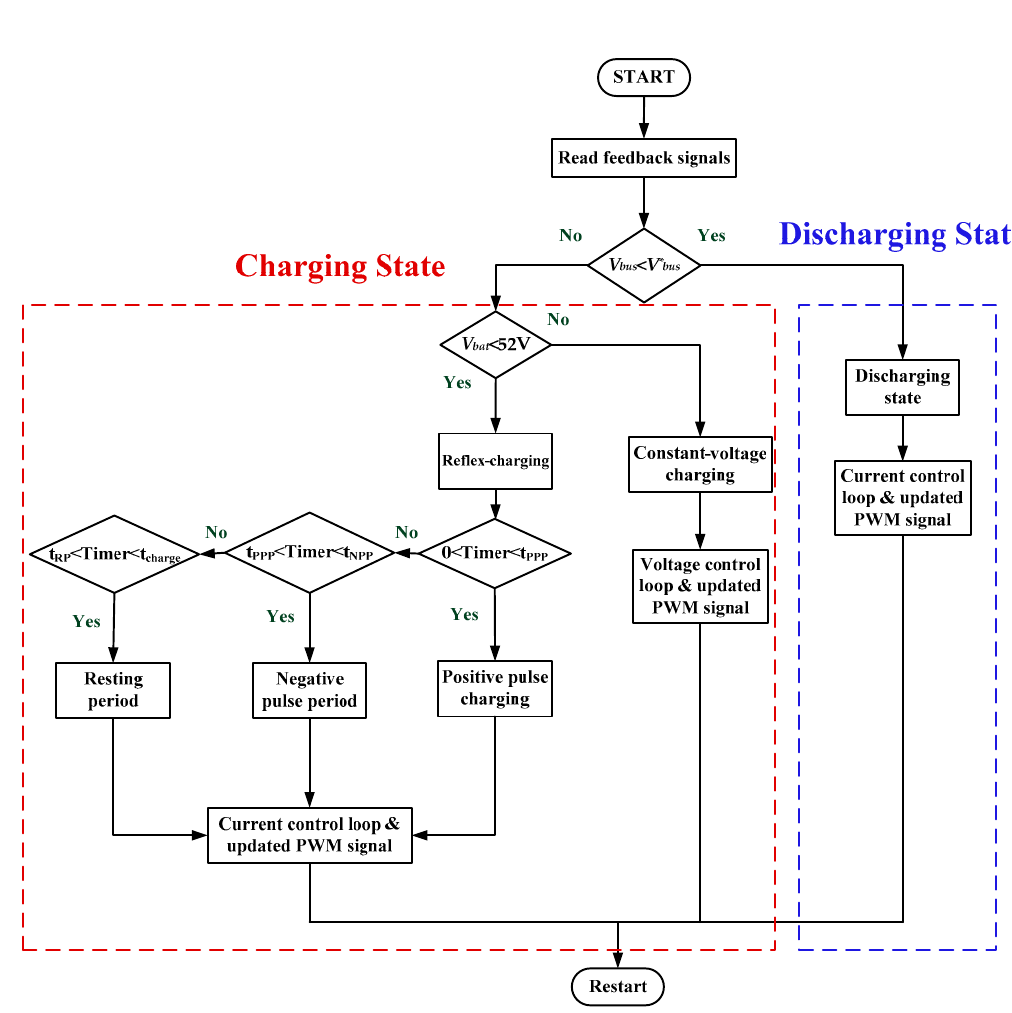
Figure 6. System operating flow chart.